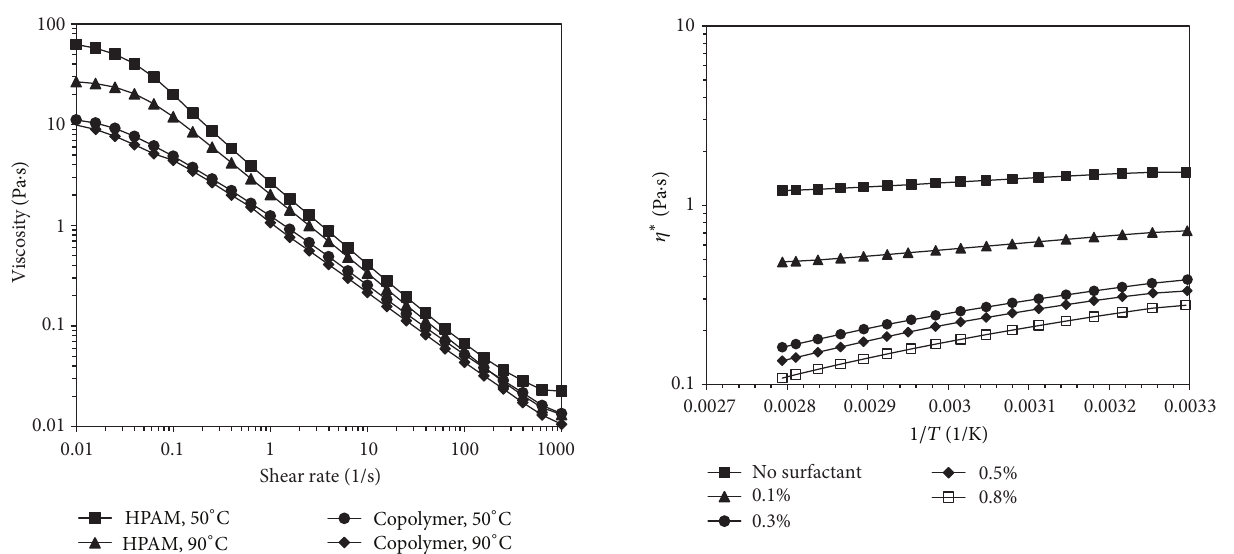
Figure 6: Steady shear viscosity profile of HPAM and ATBS-AM copolymer solutions in salt-free water without surfactant at 0.25% polymer concentration.